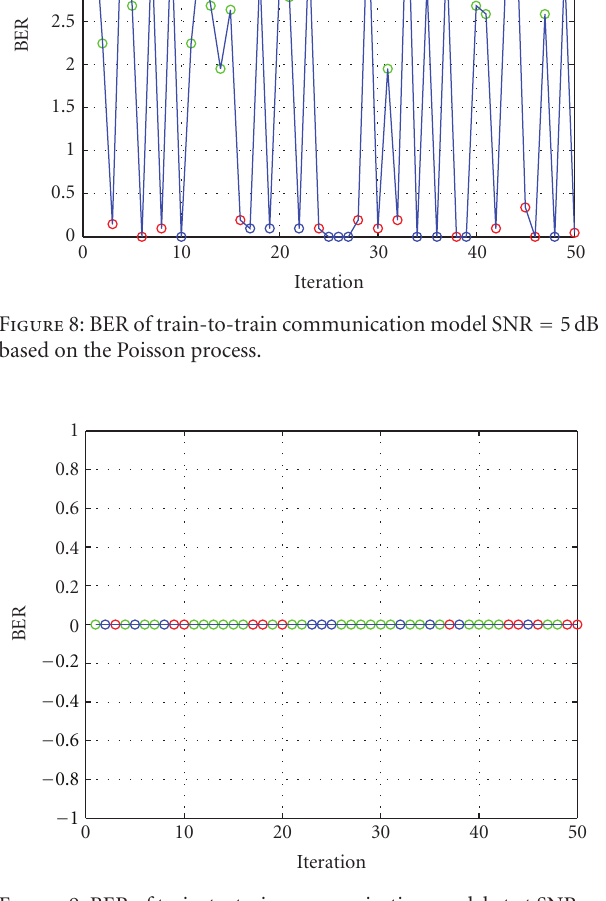
Figure 9: BER of train-to-train communication model at at SNR = 10dB based on the Poisson